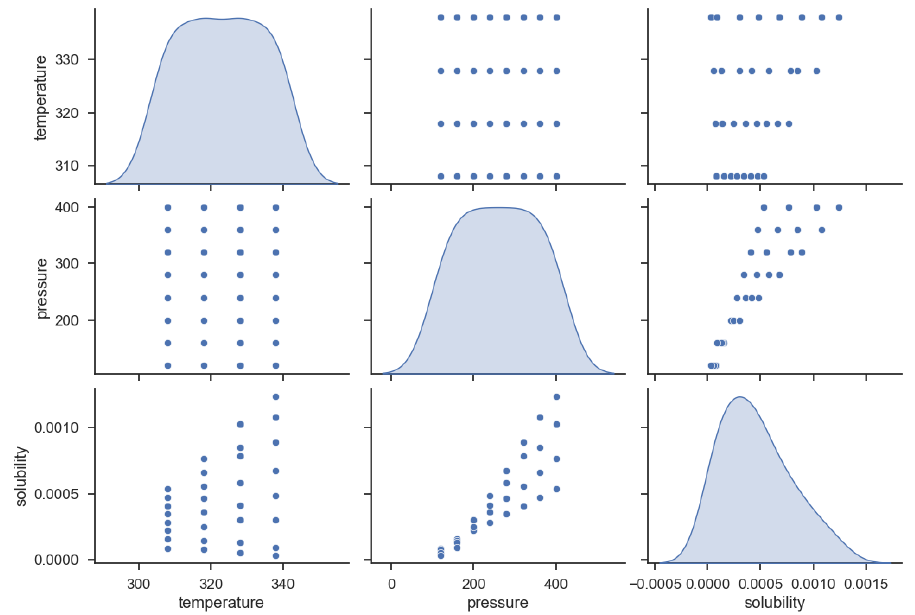
Figure 1. Pairwise Distribution of variables.